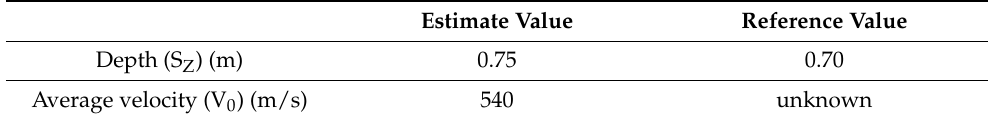
Table 3. Second example of estimation obtained with the MUSIC algorithm adapted to the problem and to Model M1 (5 sensors spaced 0.2 m apart).